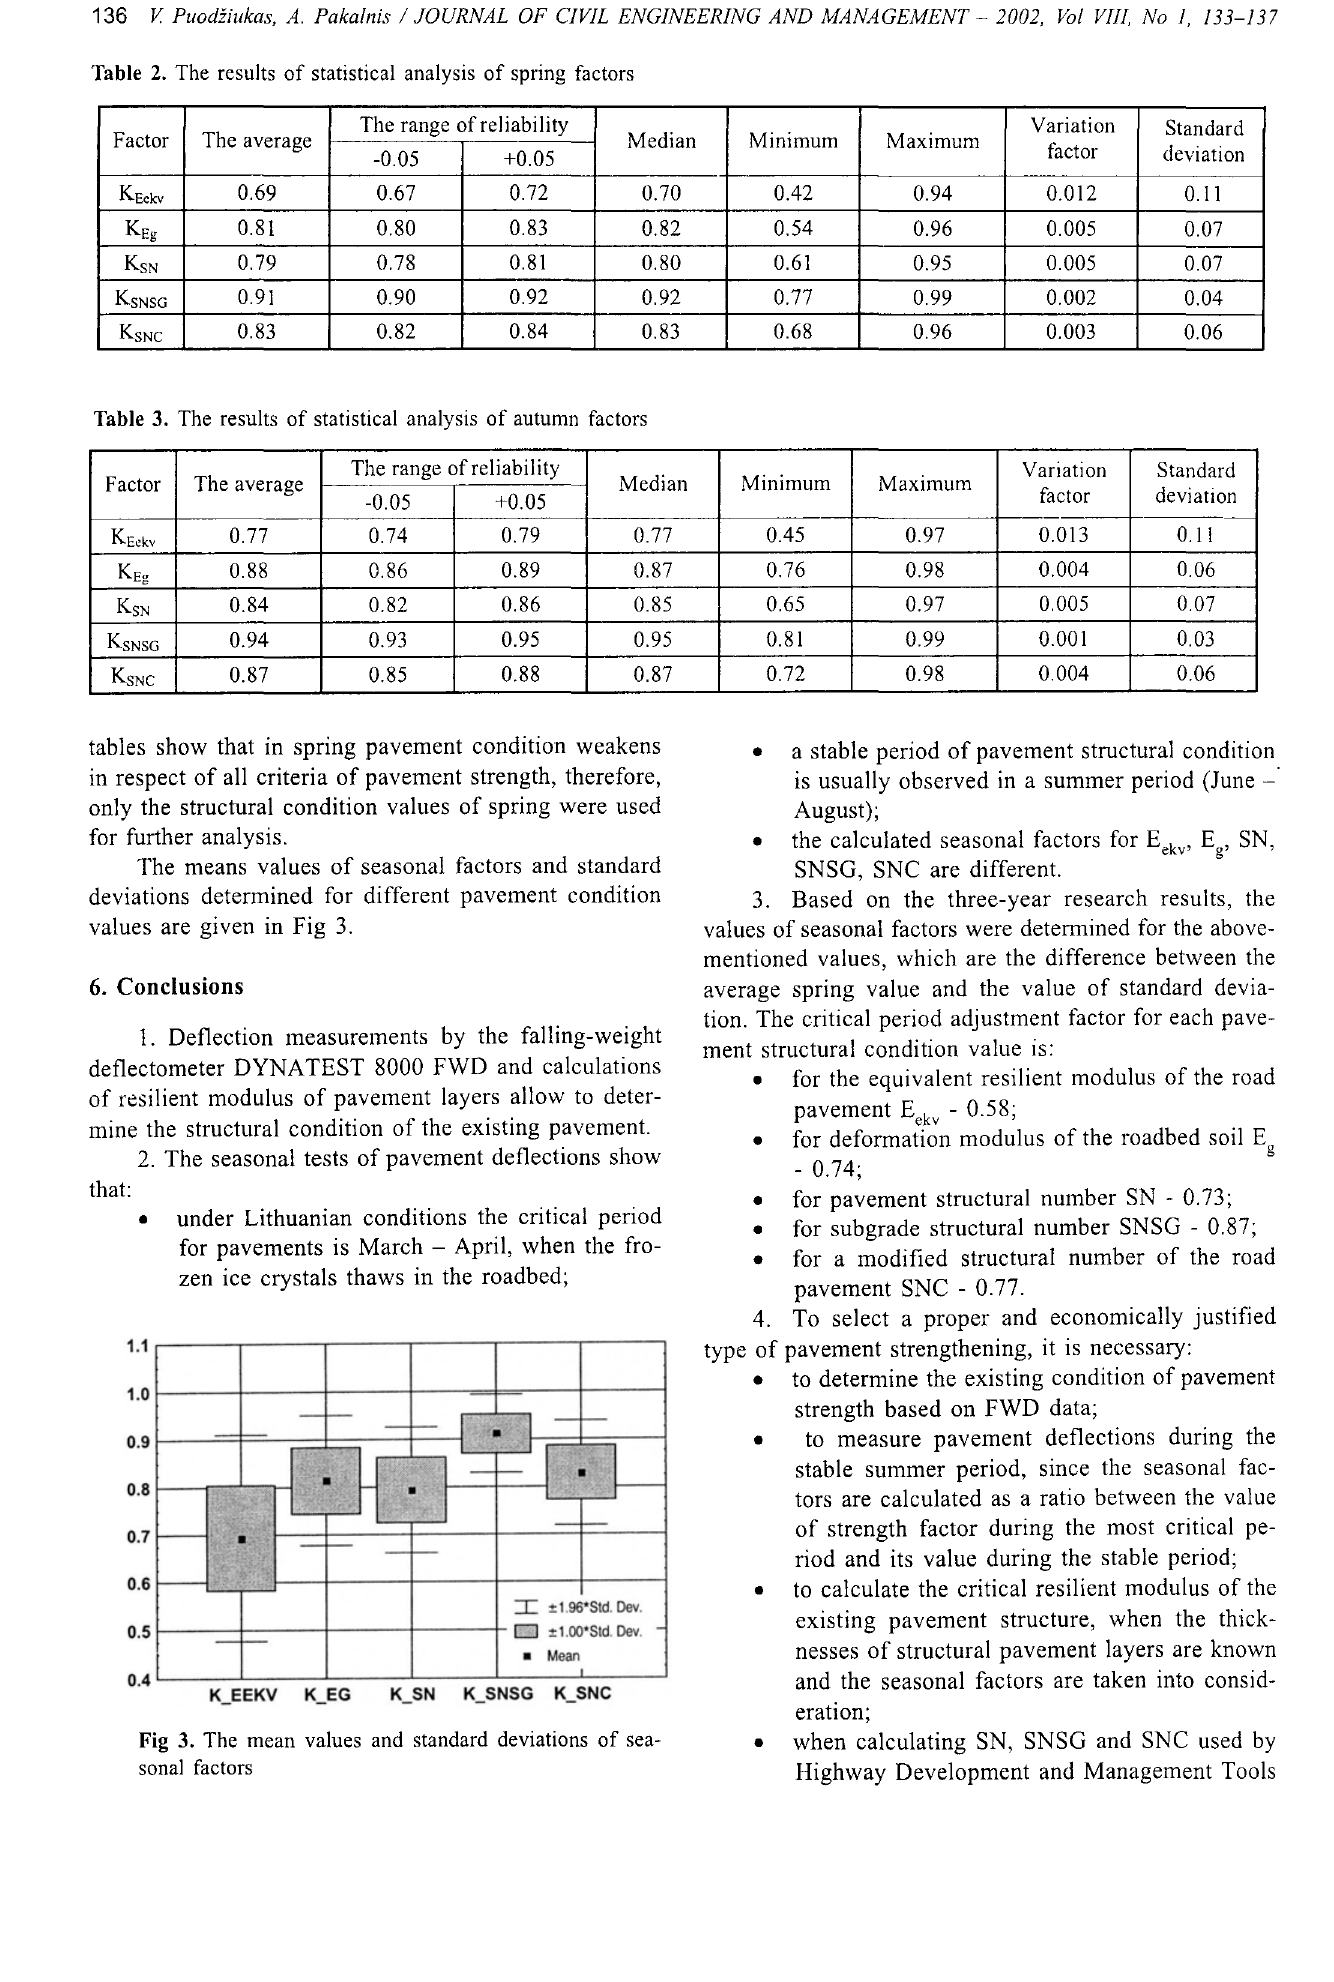
Table 2. The results of statistical analysis of spring factors The range of reliability